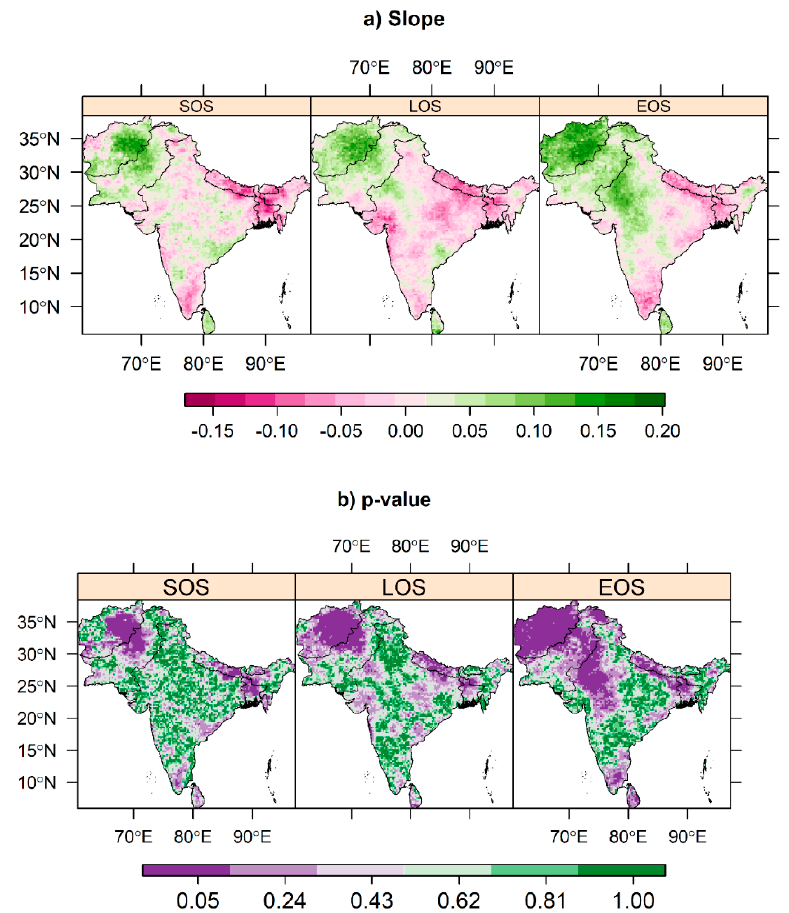
Figure 12. The spatial pattern of drought trends over south Asia during SOS, LOS, and EOS phenology stage form 2001–2016. The positive and negative values of the slope ( a ) indicate the increasing and decreasing trend of drought, and the p -value ( b ) shows the significant level ( p -value ≤ 0.05) of changing drought.